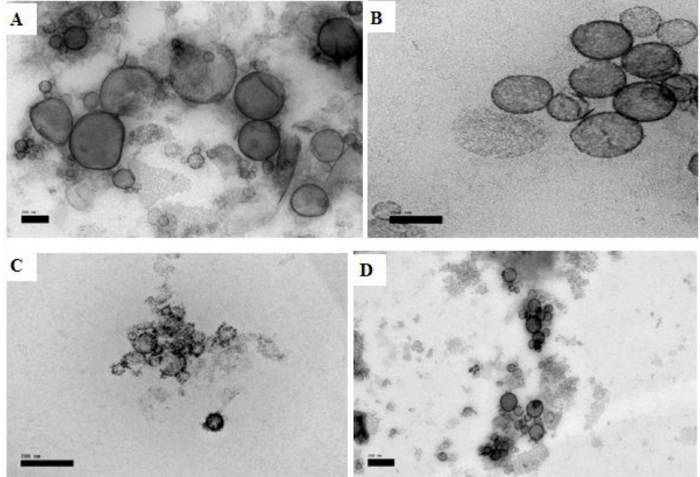
Figure 5. TEM micrographs of liposomes (scale bar: 200 nm): ( A ) control of optimized formulation (5% ( w / w ) mixed soy lecithin (ML), 0.3% ( w / w ) cholesterol (CH) and 0.75% ( w / w ) Tween80 (TW80)), ( B ) optimized squalene (SQ)-loaded liposomes (5% ( w / w ) mixed soy lecithin (ML), 0.5% ( w / w ) squalene (SQ), 0.3% ( w / w ) cholesterol (CH) and 0.75% ( w / w ) Tween80 (TW80)), ( C ) control of optimized